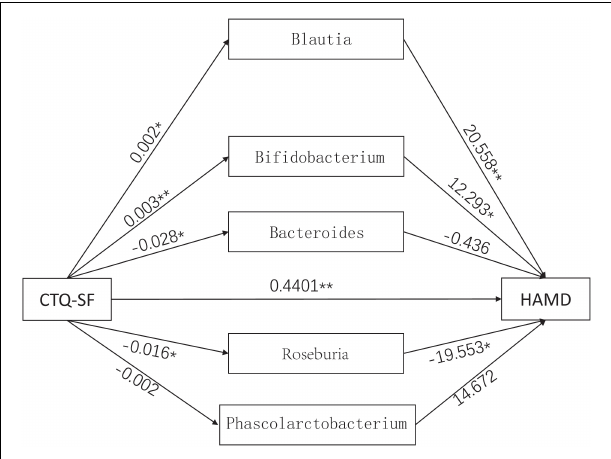
FIGURE 5 | The mediation model involving the CTQ-SF score, gut microbiota and the HAMD score. The numbers in the figure represent the effect size. * P < 0.05, ** P < 0.01.